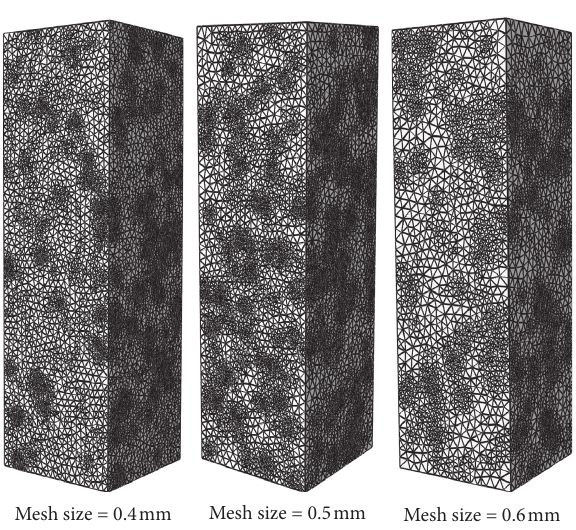
Figure 3: Mesoscale model of different mesh sizes.